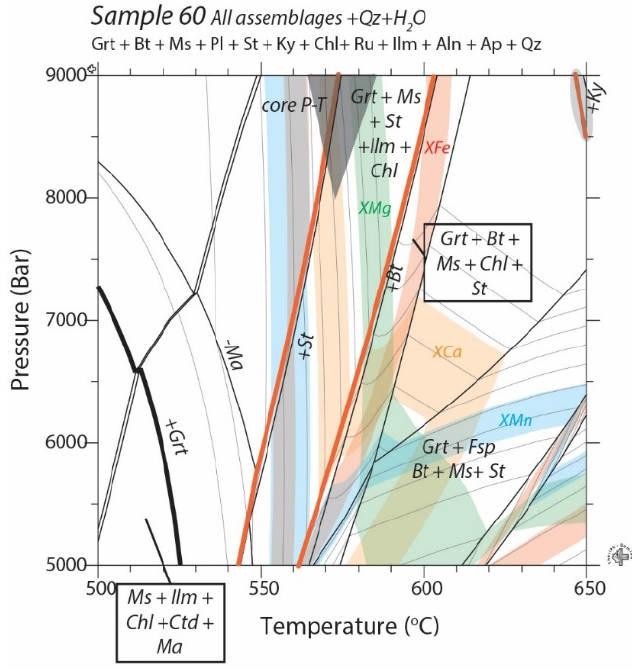
Figure 16. Isochemical phase diagram for sample 60 using data reported from [28]. Some index mineral reaction lines are indicated. The core P-T condition is located indicted by core P-T. See Figure 1 and [28] for sample locations. Garnet isopleths are indicated and do not intersect (blue = spessartine content, green = pyrope, orange = grossular, and red = almandine). Some mineral stability fields are labeled.